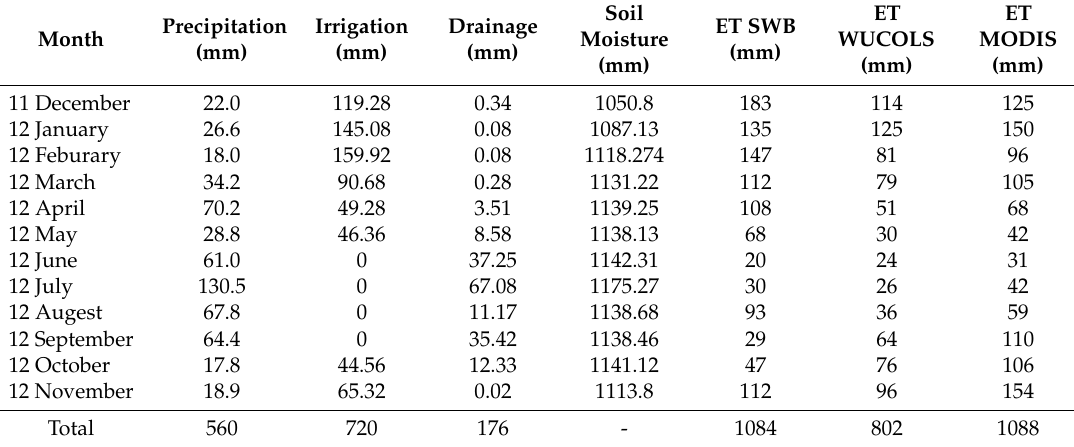
Table 1. SWB components and ET estimates in Veale Gardens, 2011–2012. Soil moisture is in mm of water in the top 4 m of the soil profile.